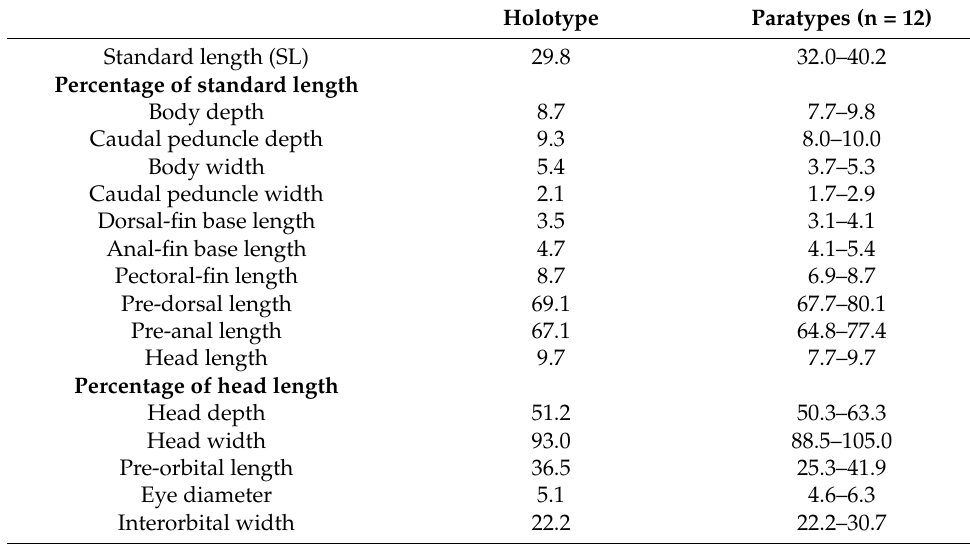
Table 2. Morphometric data of Listrura macacuensis sp. nov.